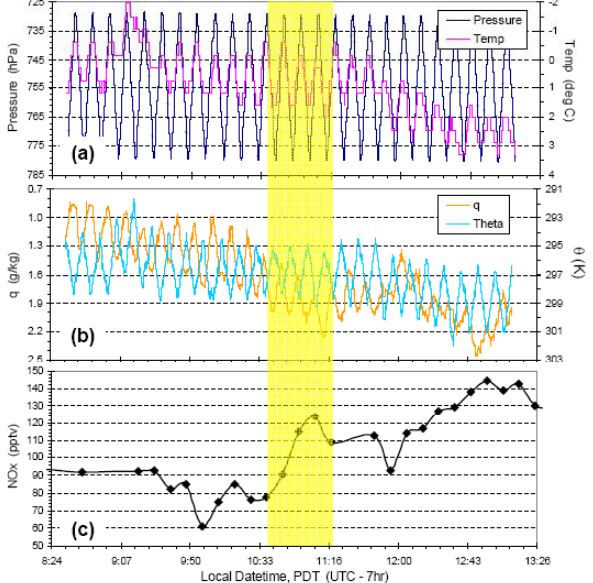
Fig. 4. Chairlift soundings of (a) ambient pressure and temperature and (b) specific humidity, q , and potential temperature, θ , along with (c) 10-min NO x data for 1 May 2008. Each “cycle” in (a) and (b) represents one full ascent and descent of the chairlift. Note the axes in (a) and (b) are inverted so the top of the plots represent the top of the mountain. The yellow box highlights the time when a transition to a regime in which the summit is beginning to be influ- enced by the BL is believed to